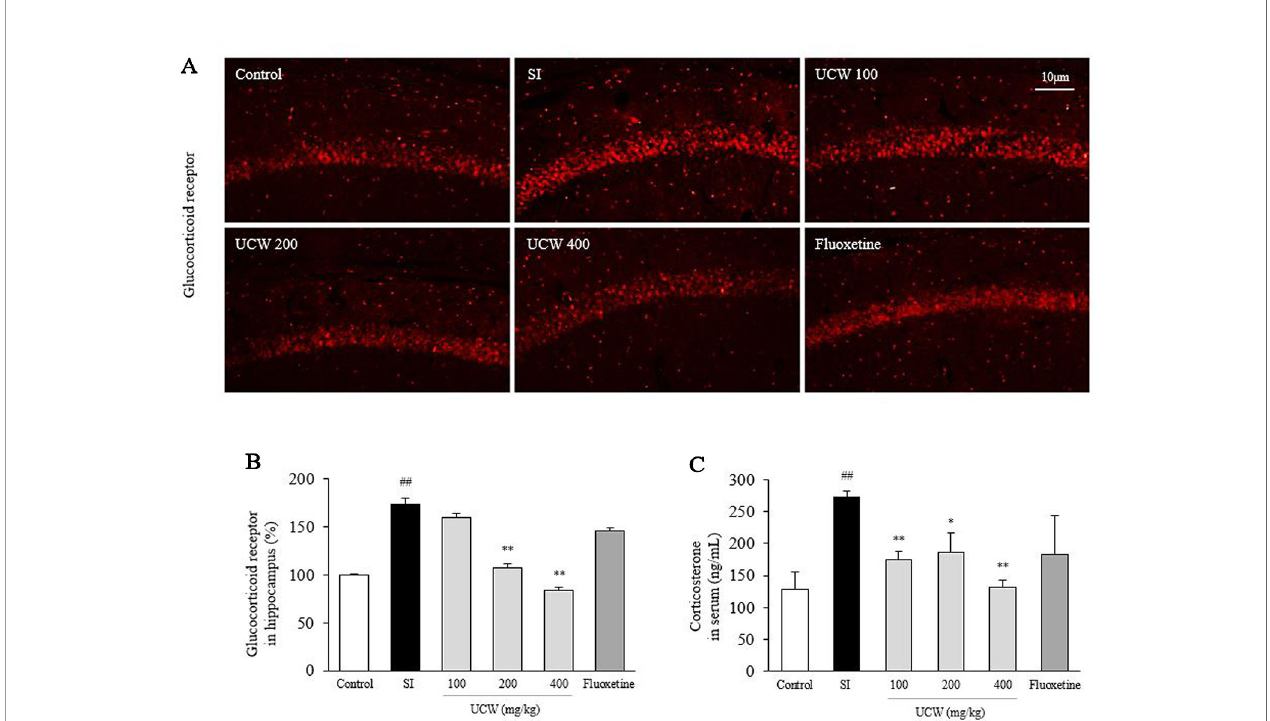
FIGURE 2 | Effects of UCW on the hippocampal GR relative intensity, the serum corticosterone, and serum ACTH level. After social isolation (31 days) with/without administration of UCW or fl uoxetine, the glucocorticoid receptor relative intensity was measured using immuno fl uorescence in the hippocampus CA1 region, and (A) the glucocorticoid receptor relative intensity was semi-quanti fi ed (B) (n = 3). The serum concentration of corticosterone (C) was measured (n = 8). Data are presented as the mean ± SD. ## P < 0.01 compared with the control group; *P < 0.05, **P < 0.01 compared with the social isolation (SI)